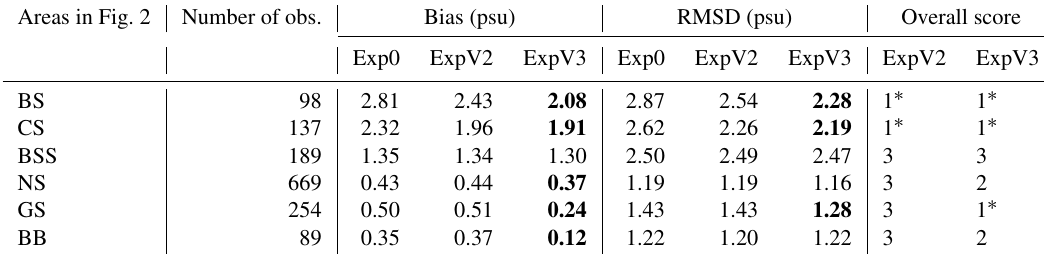
Table 2. Evaluation of SSS misfits (unit: psu) in the three assimilation runs according to the six areas indicated by the dashed blue lines in Fig. 2. The numbers in bold indicate the smallest misfit, with a reduction of at least 9% relative to Exp0. The overall score depends on whether the bias and RMSD are reduced by at least 9%. If both criteria are met, the score equals 1; it is 2 if only one of them is met, and it is 3 otherwise. The ∗ subscript means the bias changes passed the significance test using Student’s t test ( α = 0.05). Areas in Fig. 2 Number of obs. Bias (psu) RMSD (psu) Overall score Exp0